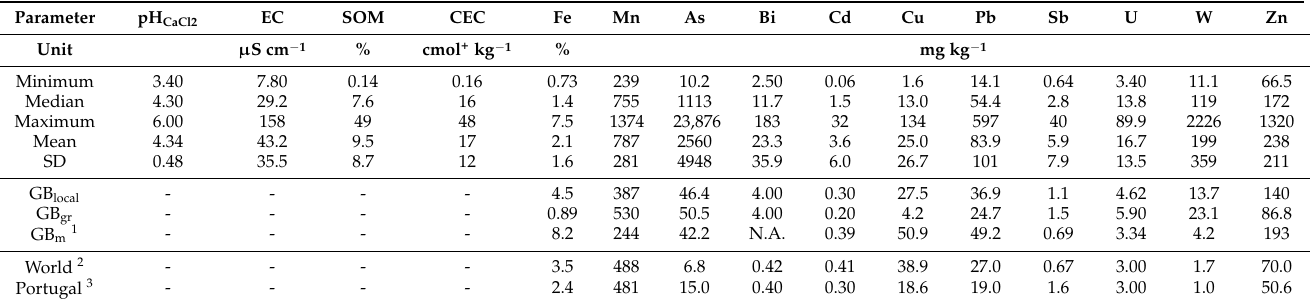
Table 1. Descriptive statistical summary of the analysed physicochemical parameters and chemical concentrations of selected elements from the topsoil samples of the Regoufe area ( n = 61). Local geochemical background values (GB local ) are an average between those determined for samples collected on granitic (GB gr ) and metasedimentary (GB m ) bedrocks (see text).